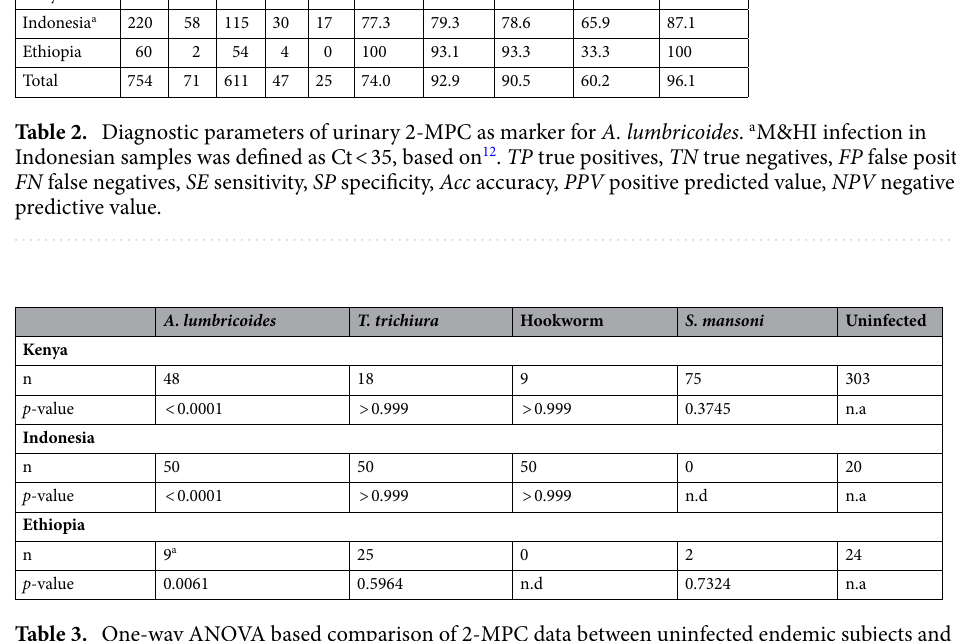
Table 3. One-way ANOVA based comparison of 2-MPC data between uninfected endemic subjects and subjects infected with A. lumbricoides , T. trichiura , hookworm or S. mansoni, respectively. a Since only 4 out of a total of 9 A. lumbricoides infected subjects was single infected, the subjects co-infected with T. trichiura were also included here. n.a. not applicable as this is the reference group, n.d. not determined.